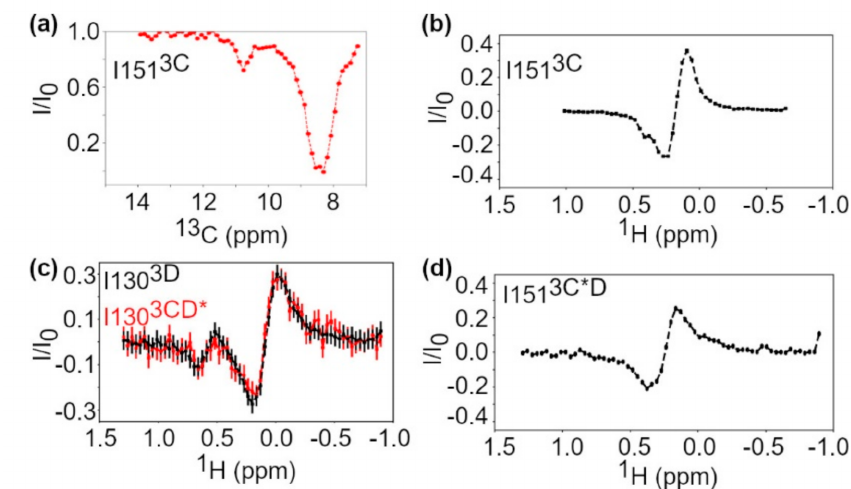
Figure 4. Chemical exchange saturation transfer (CEST) profiles for selected residues in 3C, 3D, and 3CD. Error bars were calculated from spectral noise. ( a ) 13 C CEST profile for Ile151 in 3C. The decrease in intensity at 8.5 ppm is because the 13 C chemical shift for Ile151 is at 8.5 ppm. The decrease around 11 ppm is due to conformational exchange. ( b ) 1 H CEST profile for Ile151 in 3C. For the 1 H CEST experiments used here, the measured intensity is only non-zero when the observed resonance or a state it is exchanging to has 1 H chemical shift around the saturating frequency. ( c ) 1 H CEST profile of Ile130 in 3D (black) and 3CD (red, 3D numbering). ( d ) 1 H CEST profile for Ile151 in